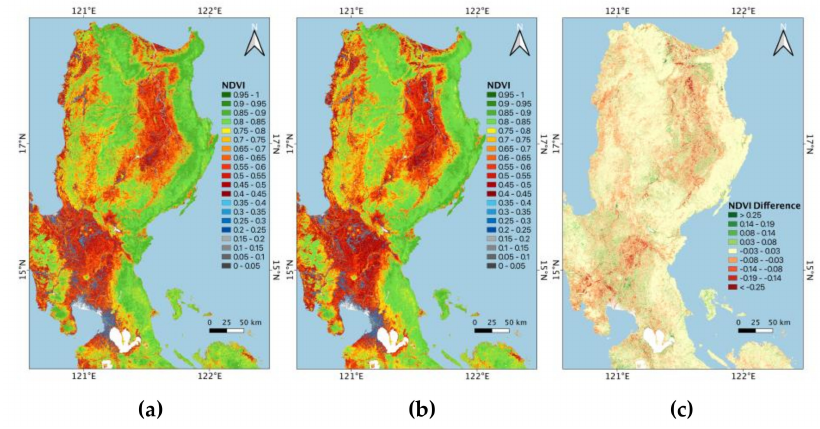
Figure 6. NDVI composites in Northern Luzon during April for the period ( a ) 2008 to 2010; and ( b ) 2017 to 2019, representing the state of vegetation before and after the NGP, respectively; and ( c ) their di ff erence (b minus a) depicting net gain or